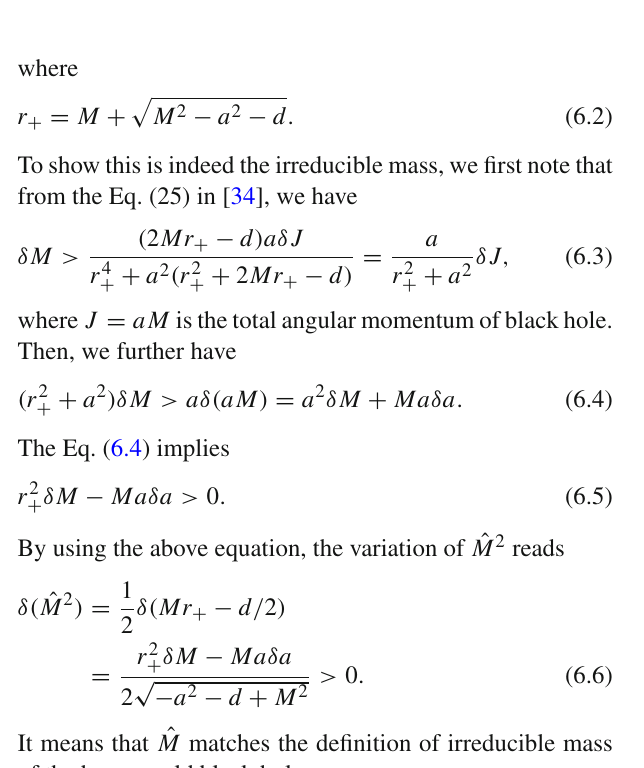
Fig. 7 The maximal efficiency of η as a function of d